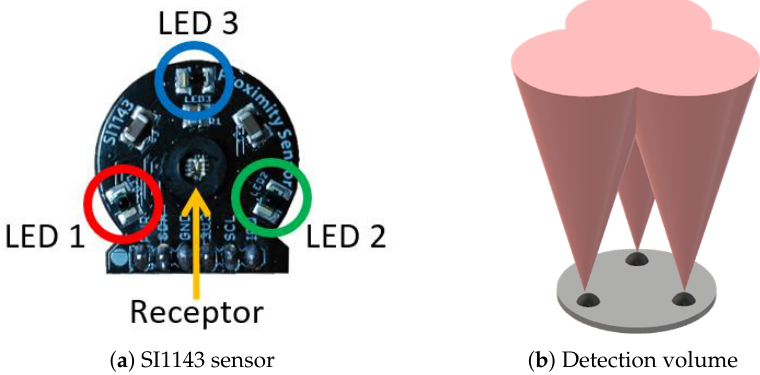
Figure 3. Proximity sensor and approximate detection